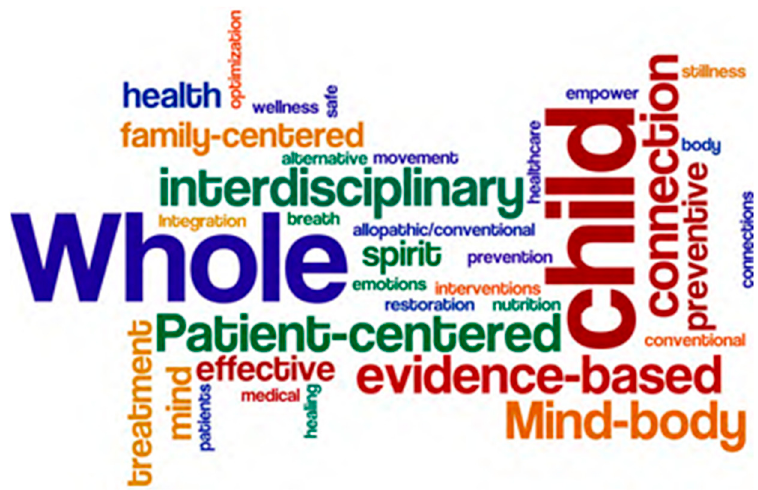
Figure 2. What does integrative medicine mean to you?